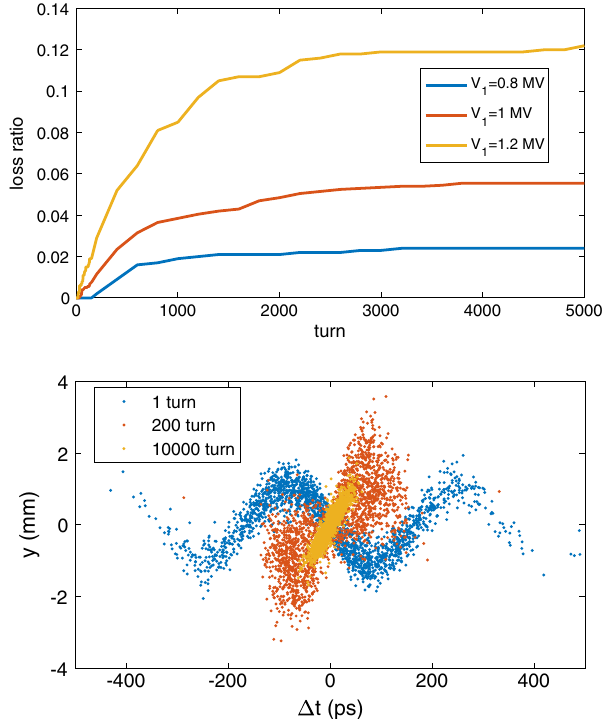
FIG. 5. Top: injection loss ratio vs number of turns for crab cavity voltages V 1 ¼ 0 . 8 , 1, and 1.2 MV. Bottom: the injection beam distribution in y - Δ t coordinates for the V 1 ¼ 1 MV case after the first turn, 200 turns, and 10,000 turns. The vertical acceptance corresponds to a (cid:3) 3 . 5 mm vertical aperture at the location.